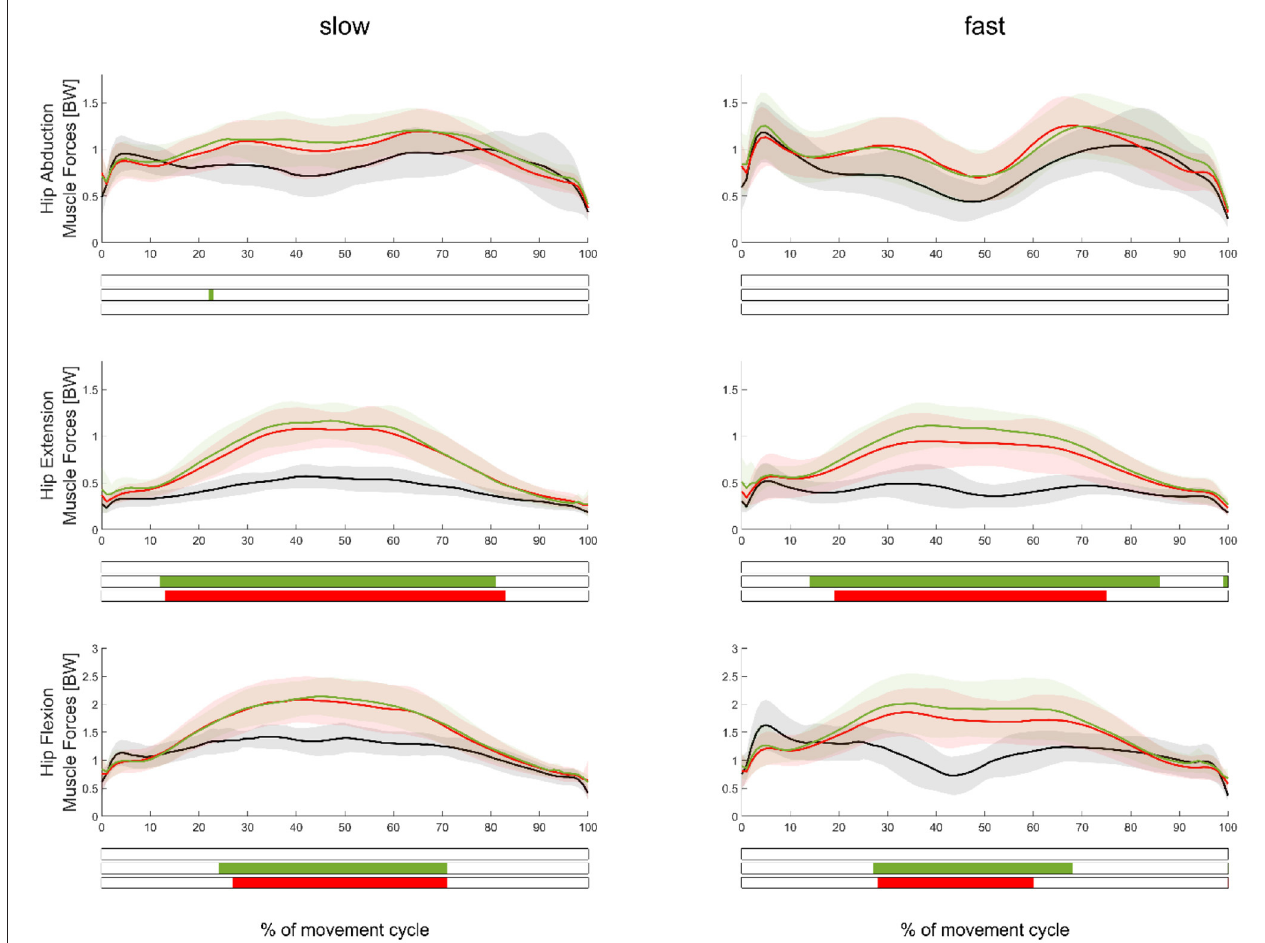
FIGURE 3 | Mean ( ± SD) muscle force waveforms measured in the movement leg during hip abduction (top), extension (middle), and flexion (bottom) exercises, as well as during slow (left subplots) and fast (right subplots) velocities. Green, red, and black waveforms represent the stiffer, softer, and no ERB, respectively. Colored bars beneath each plot indicate significant differences between waveforms, whereas the green, red, and blue (first) bars represent significant differences between the stiffer vs. no ERB, softer vs. no ERB, and stiffer vs. softer ERB,